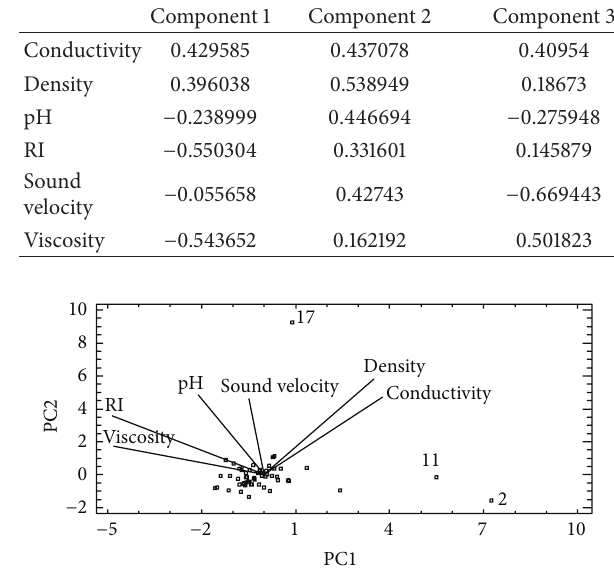
Figure 1: Distribution of physicochemical properties of tequila brands in the plane of the first two